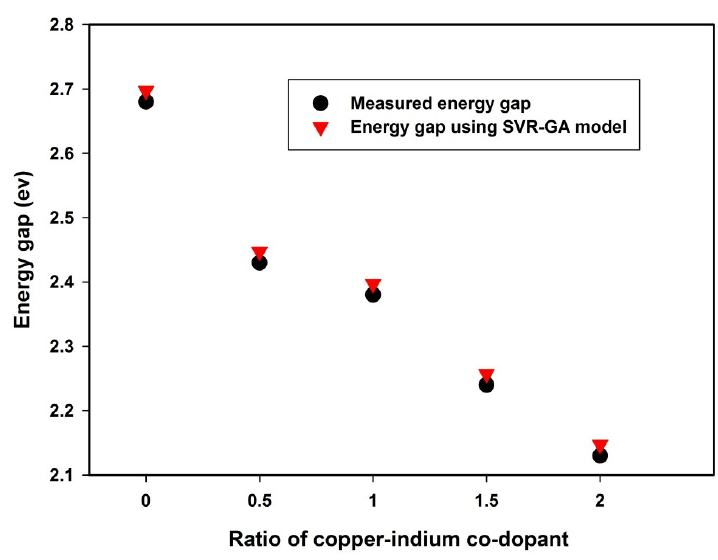
Figure 4. Effect of copper–indium co-doping (ratio) on energy gap of sulfur-based